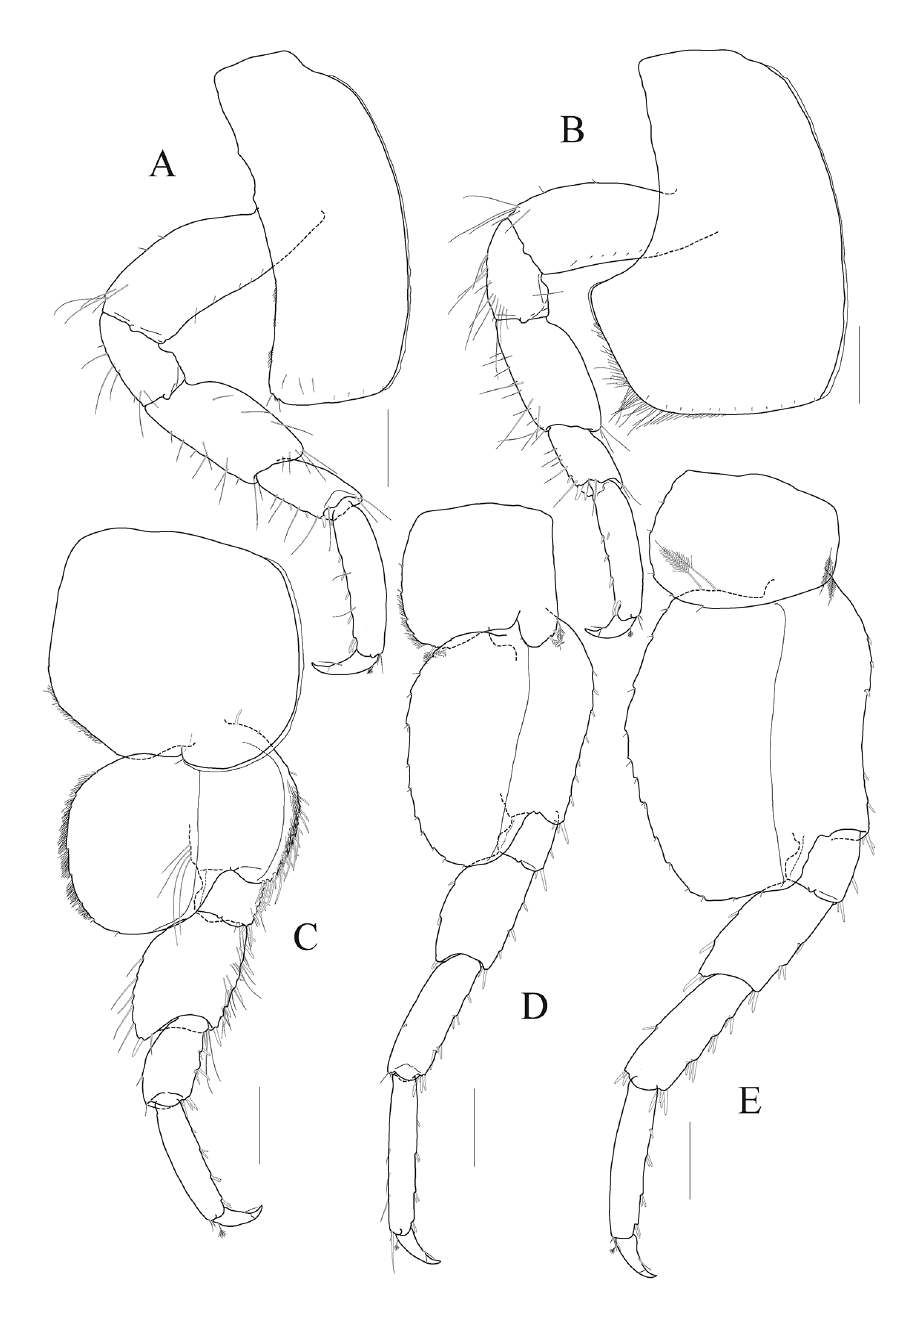
Figure 3. Aroui minusetosus sp. n., holotype male, NIBRIV0000806536, 4.3 mm. A pereopod 3 B pere- opod 4 C pereopod 5 D pereopod 6 E pereopod 7. Scale bars 0.2 mm ( A–E